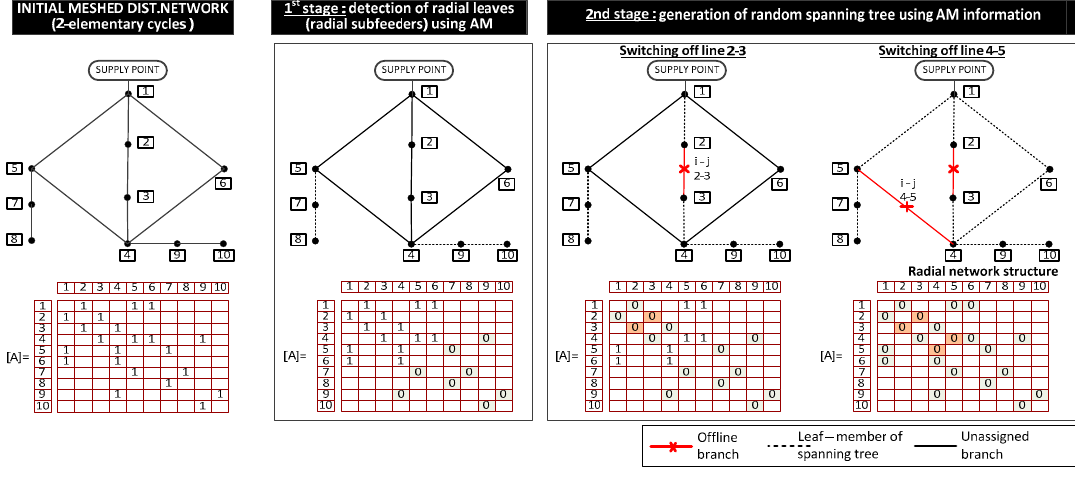
Figure 1. Illustration of AM cycle break algorithm.